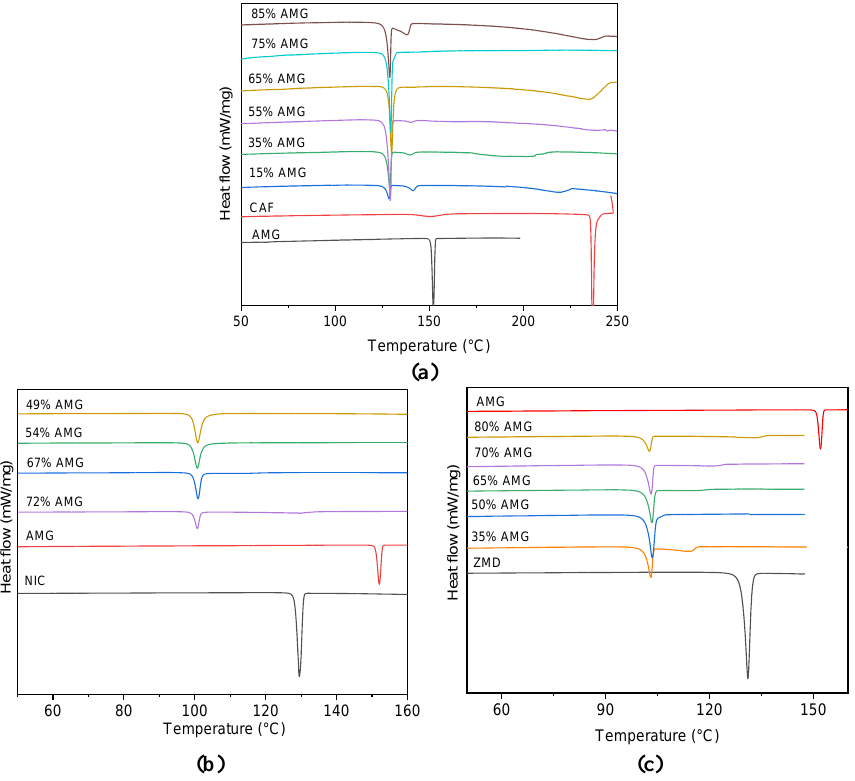
Figure 3. DSC patterns of the different AMG-coformer compositions showing the melting point depressions and the eutectic peak, ( a ) AMG and CAF, ( b ) AMG and NIC, and ( c ) AMG and ZMD. The thermogram of AMG exhibits only one endothermic melting peak, suggesting no polymorphic transition during the heating cycle. The eutectic melting peak for the AMG-NIC system (Figure 3b) is found at 99.2 °C, being, as expected, significantly lower than for both the starting materials. A close-to single eutectic peak is observed for the ~ 50% mixture, indicating the presence of the “purely” eutectic phase and thus, the eutectic composition in the AMG-NIC system. In the case of the AMG-CAF system at different weight% ratios, except at the eutectic composition, DSC curves exhibited three endother- mic transition effects (see Figure 3a). The first endothermic peak signifies the eutectic tem- perature, whereas another endotherm signifies the melting of excess AMG or CAF, re- spectively. The supplementary peak observed at 137.7 °C corresponds to the enantiotropic phase transition of caffeine polymorphic form II to form I [25,26]. The eutectic composition is found to be close to 75 wt.% AMG composition. For the AMG-ZMD system, the melting endothermic peak at 101.8 °C refers to the eutectic melting (see Figure 3c), while the eu- tectic composition is found close to the AMG-ZMD composition of ~50 wt.%. Table 1 con- tains the measured temperatures and enthalpies of melting for the pure AMG, the coformers used and their eutectic mixtures. Hot stage microscopic analysis results of the eutectic mixtures which are presented in Figure S1 (Supporting Information), also support